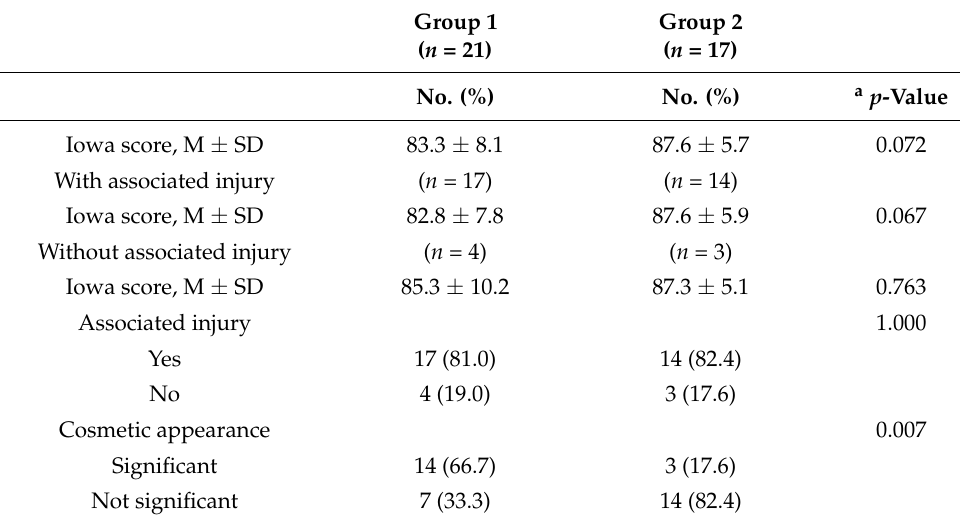
Figure 4. A 27-year-old man with anterior and posterior pelvic ring injury. The “R” on the plane radiography represents the right side of the patient. ( a – c ) Preoperative pelvic radiology series (anteroposterior, inlet, and outlet views) showing right sacral fracture (Denis zone II) with diastasis of the bilateral sacroiliac joint and of pubic symphysis with fracture of the left anterior pubic ramus. ( d – f ) Postoperative pelvic radiology series (anteroposterior, inlet, and outlet views) demonstrating bilateral percutaneous sacroiliac screws, minimally invasive spinopelvic fixator, and dual plate fixation for anterior pelvic ring. ( g ) Postoperative lumbar and sacral lateral view showing good position of sacroiliac screw and spinopelvic fixator of the L5 and ilium. Table 3. Iowa score and cosmetic